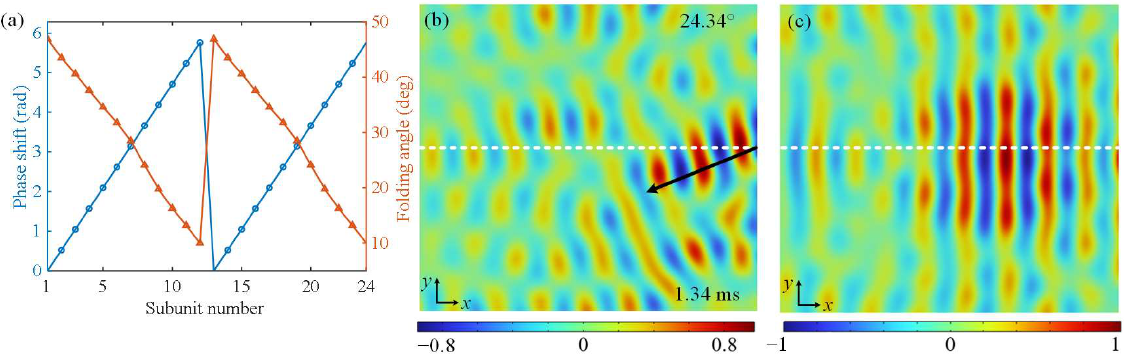
Figure 5. ( a ) Distribution of the phase shift obtained from the GSL and the distribution of the folding angle obtained from the numerical simulations in the metasurface. ( b ) Numerical simulation results of the reflected flexural wave field when n is 12 at 8000 Hz. ( c ) Numerical simulation results of the reflected flexural wave field without the metasurface at 8000 Hz.